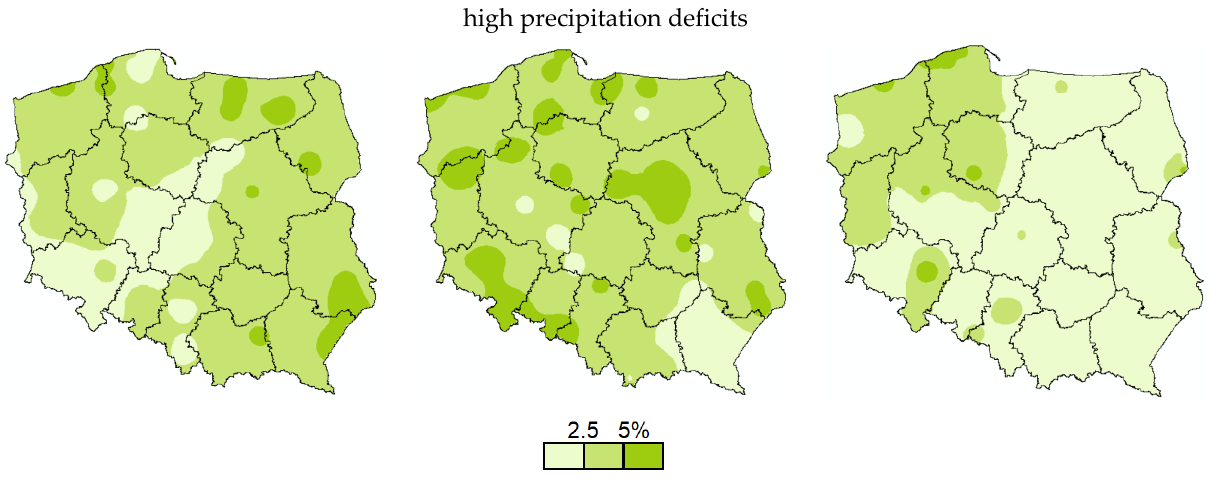
Figure 11. Spatial distribution of air temperature deviations in spring from the multi-year mean in the years when deficient precipitation covered the largest area of Poland.